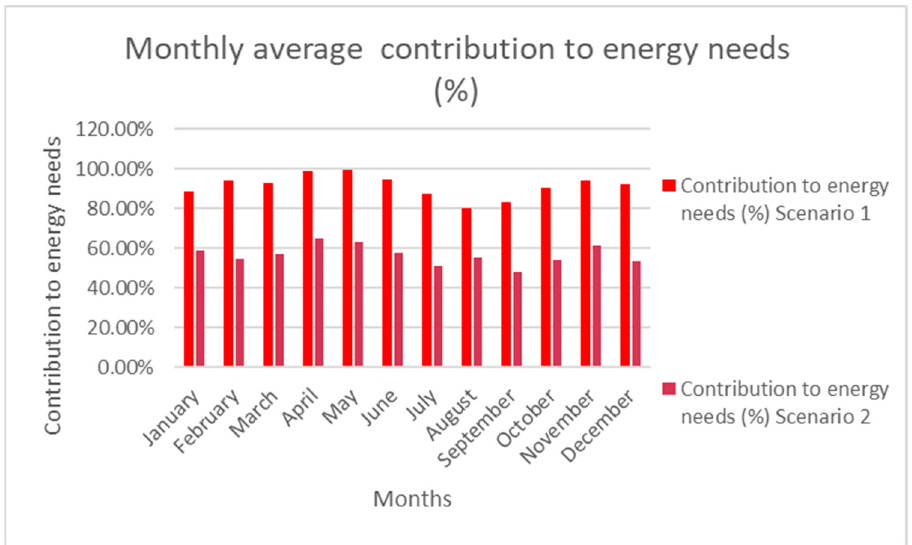
Figure 14. Monthly average contribution to energy needs.